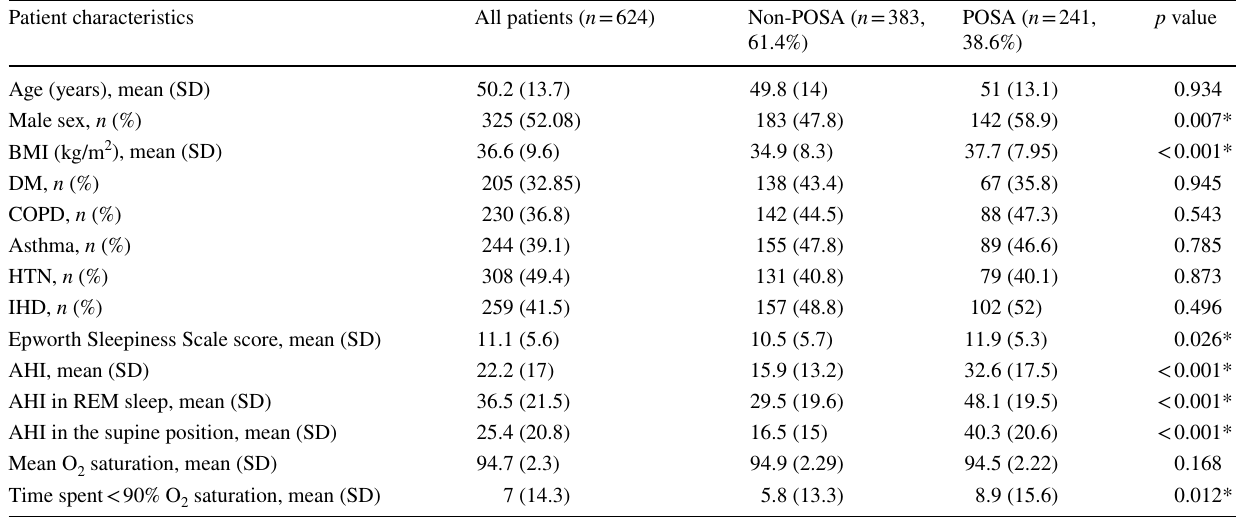
Table 4 General characteristics of patients classified according to POSA Definition 2